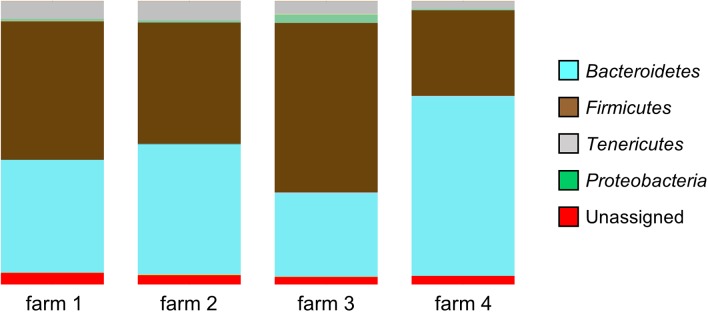
Microbial diversity at phyla level of the samples coming from four different farms showing significant differences in community composition (p < 0.001, DirtyGenes test). The percentage of Proteobacteria from Farm 4 was significantly lower than from the other farms (p < 0.0001, Kruskal–Wallis test).